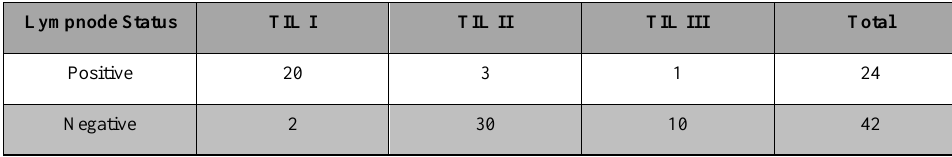
Table 6. TIL Score correlation with Lymph node